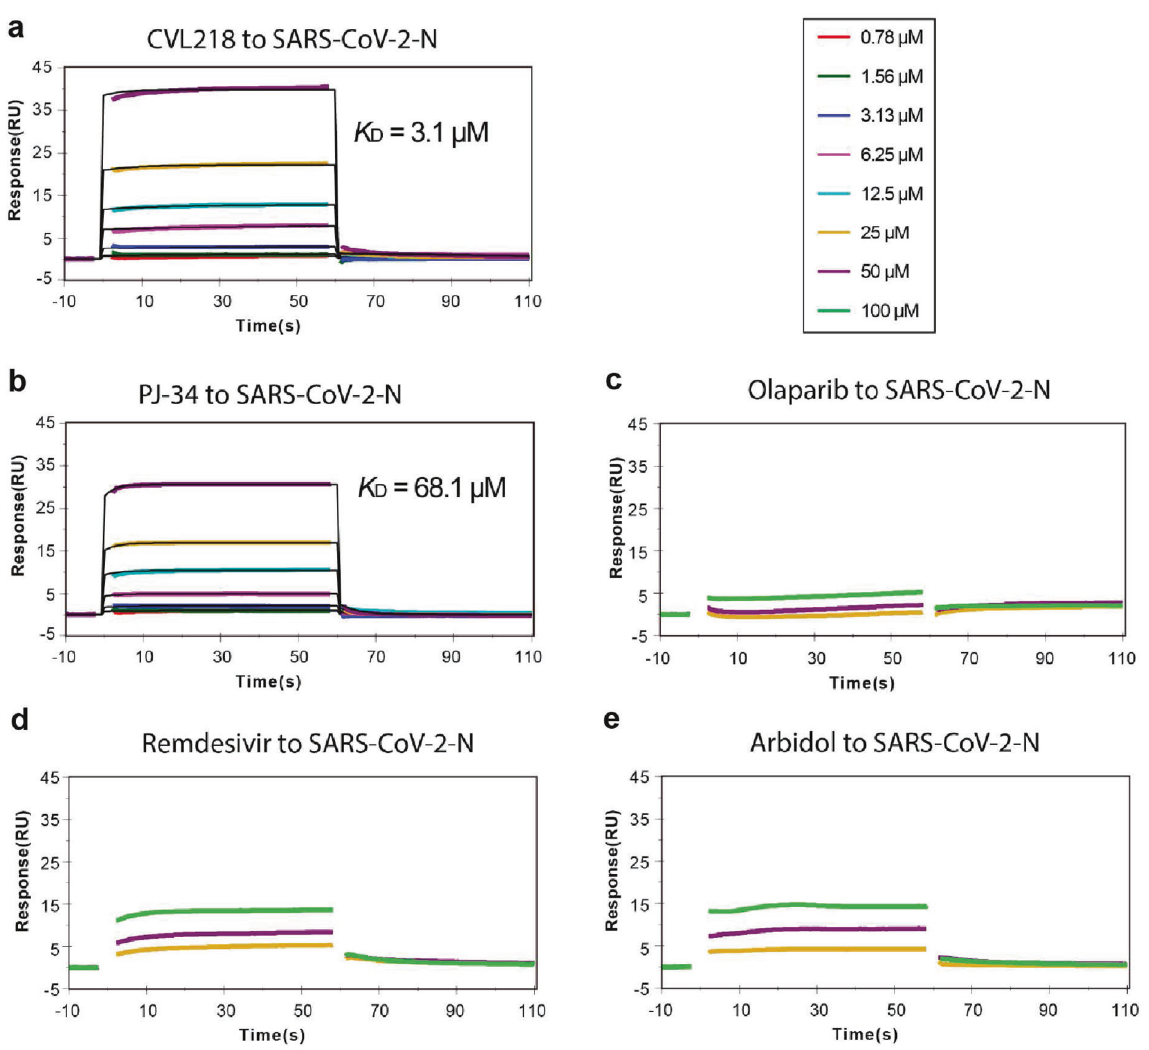
Fig. 3 CVL218 binds to the nucleocapsid protein of SARS-CoV-2 (SARS-CoV-2-N). a – e Kinetic analyses of the binding between SARS-CoV-2-N and the tested drugs, including CVL218 ( a ), PJ-34 ( b ), olaparib ( c ), remdesivir ( d ), and arbidol ( e ), measured by a SPR-based Biacore instrument. The derived dissociation constants between SARS-CoV-2-N and the tested drugs (CVL218 and PJ-34) are also